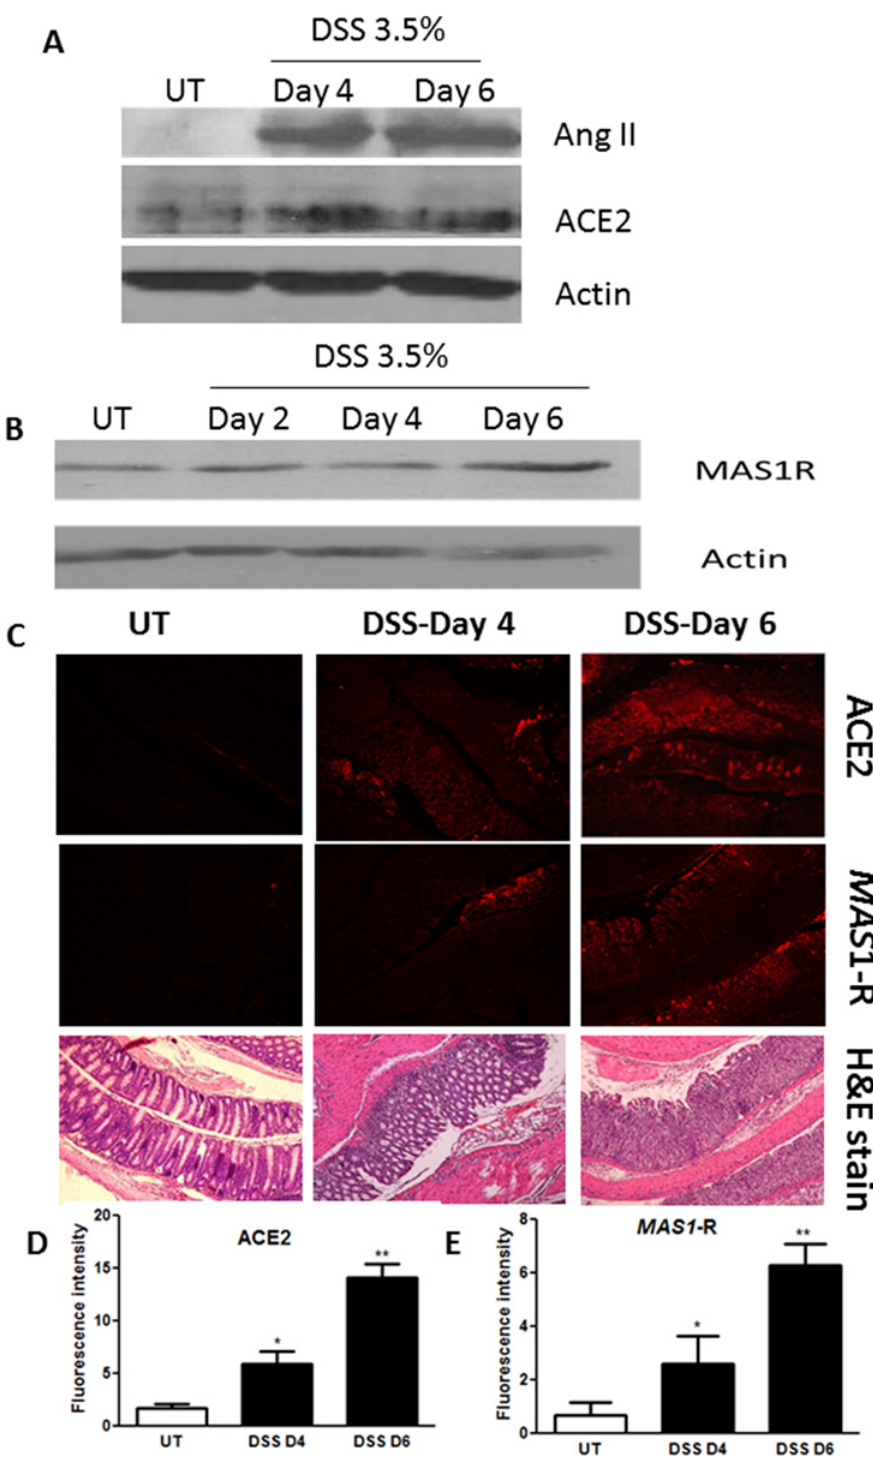
Fig 2. Effect of DSS treatment on the levels of the RAAS components. Colonic protein levels of Ang II and ACE2 (A), and MAS-1 R (B) were determined by western blotting at various times post colitis induction with DSS (blots represent one of 3 similar experiments). Panel C shows immunofluorescence staining of ACE2 and MAS-1 R in untreated mice (UT) and at days 4 and 6 post colitis induction, predominantly in the mucosal layers, as evidenced from the H&E staining. Histobars in panels D and E represent the mean ( ± SEM) fluorescence intensity for 3 mice per group for ACE2 and MAS-1 R respectively. Asterisks indicate significant difference from UT group with p < 0.05 ( * ) and p < 0.001 ( **